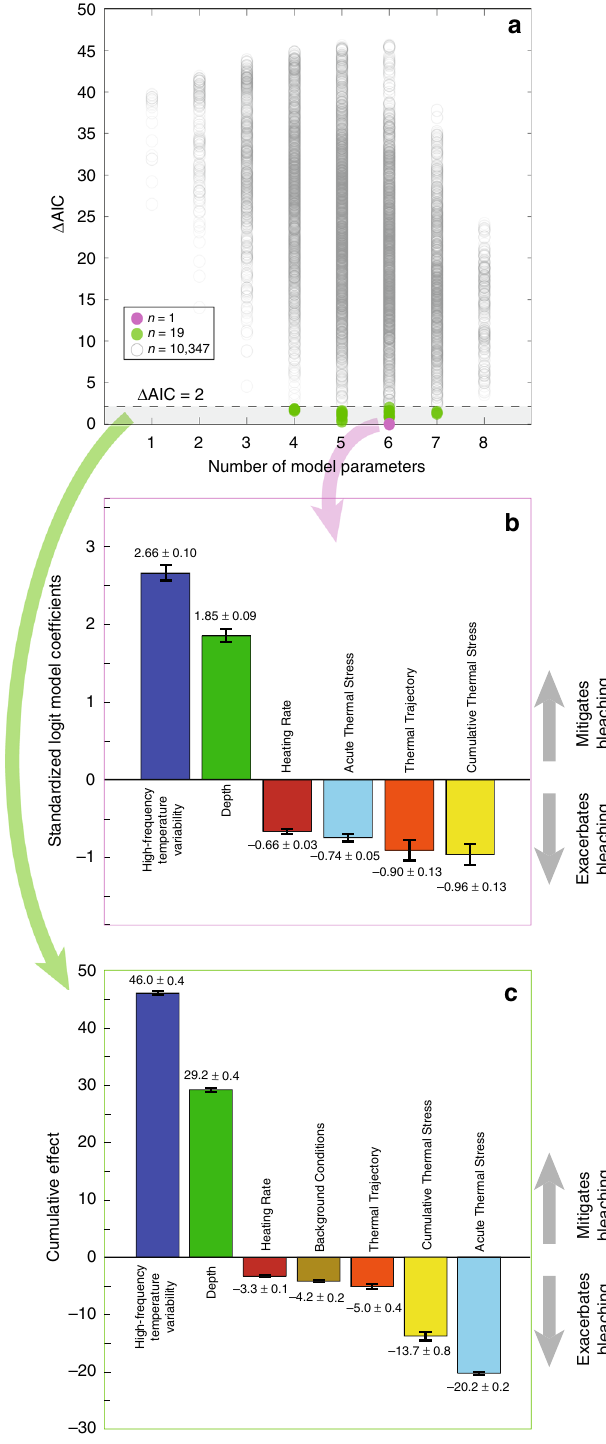
summertime bleaching susceptibility 25 . The “ Thermal Trajectory ” (Table 1) category followed the methodology of a previous study that highlighted the role of protective warm, pre-stress tempera- acute stress temperature events 39 . Our results reinforce recent fi ndings that a reef ’ s thermal trajectory is a signi fi cant predictor of